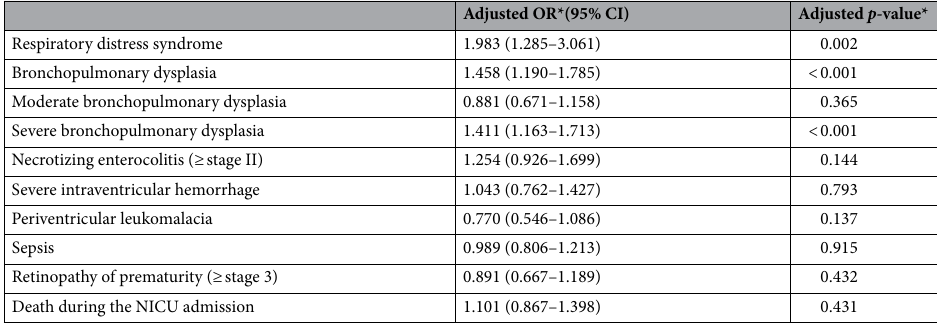
Table 3. Adjusted odds ratios and p -values for neonatal mortality and morbidities of infants with PIH mothers compared to those of infants with non-PIH mothers. *The ORs and p -values were calculated using logistic regression analysis with adjustment for maternal age, maternal premature rupture of membrane, antenatal steroids, mode of delivery, gestational age, small for gestational age, and sex. PIH Pregnancy-induced hypertension; OR Odds ratio; CI Confidence interval; NICU Neonatal intensive care